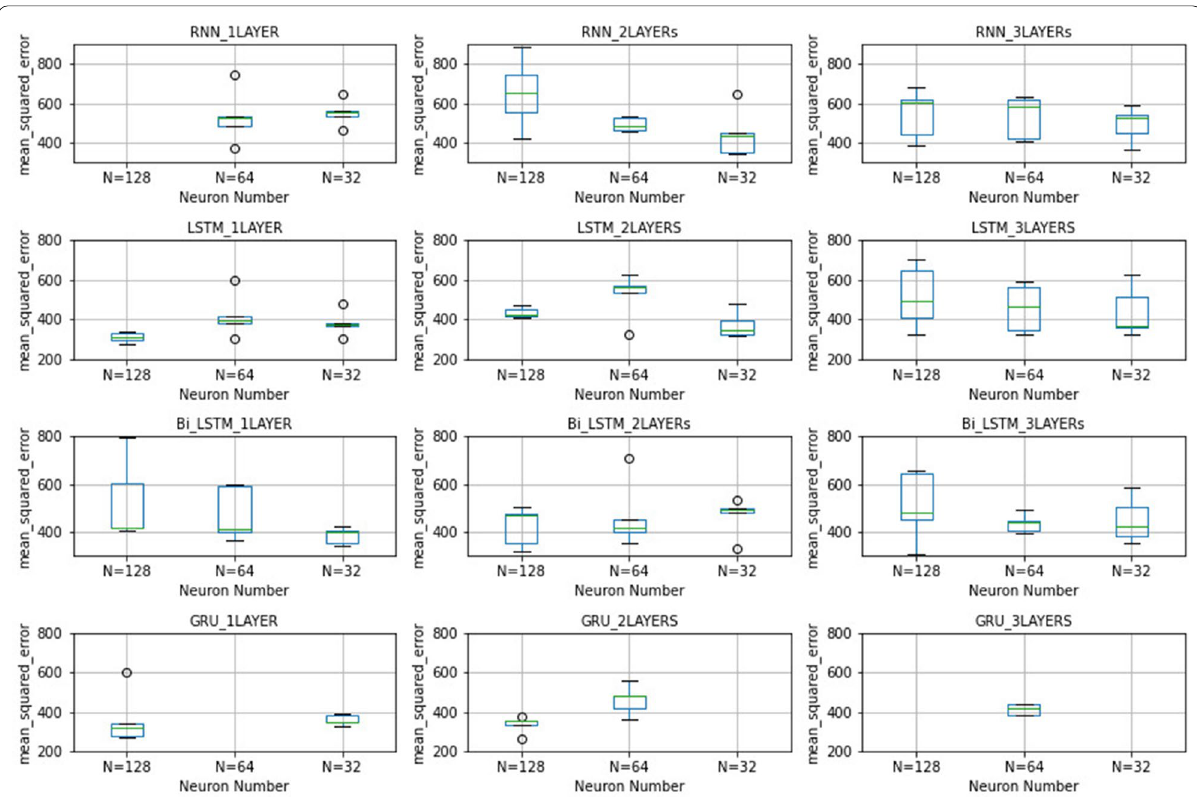
Figure 9 Performance of different Neuron number on test dataset